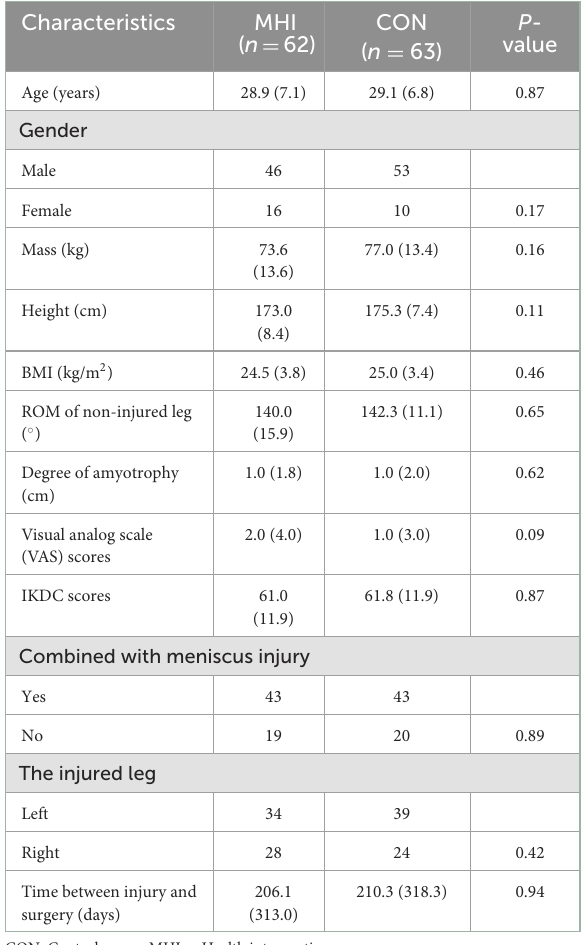
TABLE 2 Mean (SD) baseline characteristics of the participants.